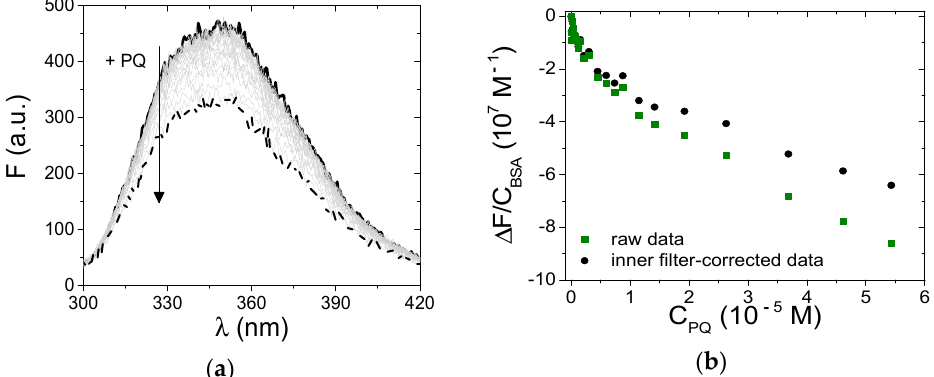
mM, pH 7.0, 25.0 °C, λ exc = 295 nm; squares refer to uncorrected fluorescence values, circles define the trend corrected according to the equation in the text.